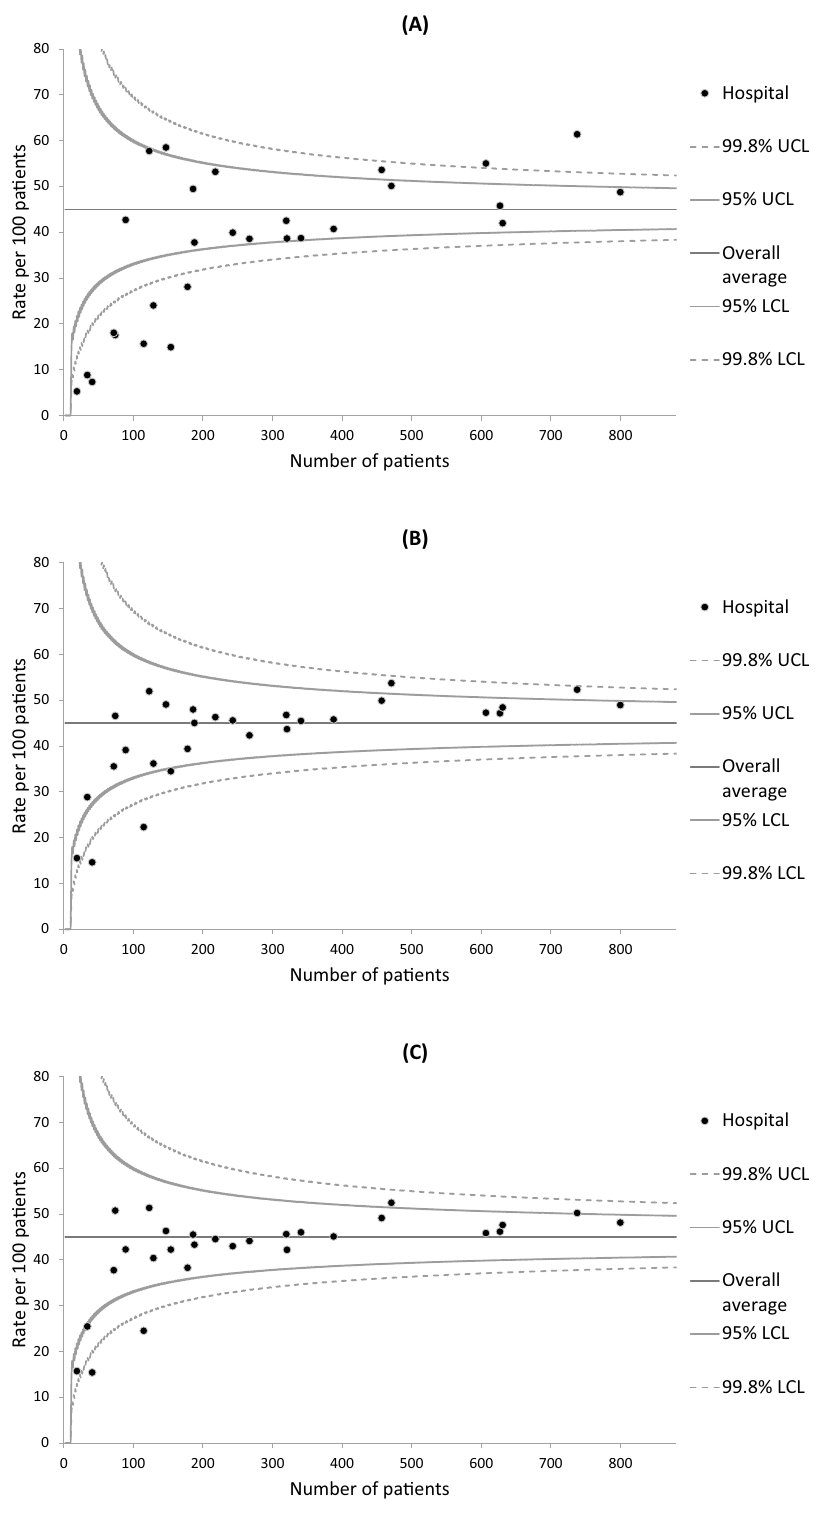
Figure 4. Funnel plots of 3-year survival and the number of lung cancer patients in each hospital. ( A ) Unadjusted survival; ( B ) Partially adjusted survival that controlled for age, sex, cancer stage, and histology; and ( C ) Fully adjusted survival that controlled for comorbidities, activities of daily living, type of admission, smoking status, and body mass index in addition to the variables in the partially adjusted model. LCL lower control limit, UCL upper control